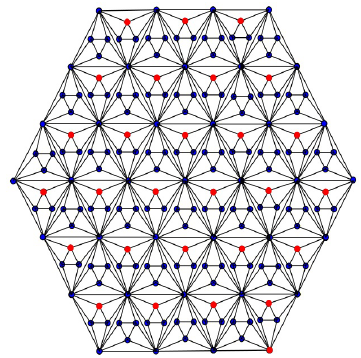
Figure 2. Third type of hex-derived network ( HDN 3 ( 4 )